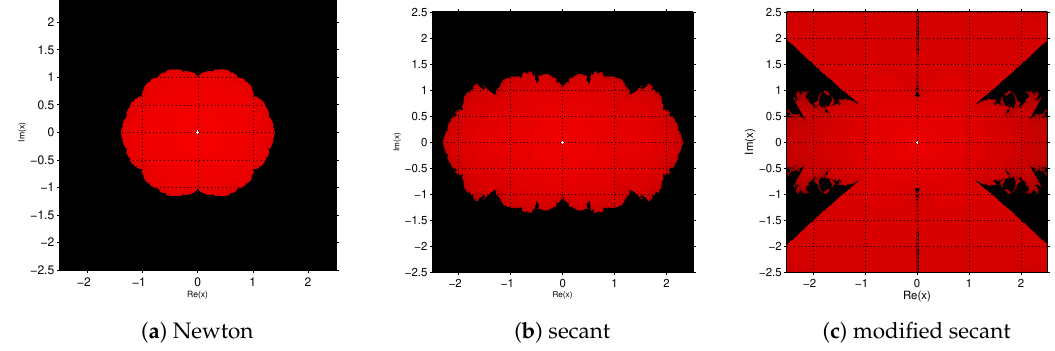
Figure 4. Dynamical planes for f 3 ( z ) = arctan z .